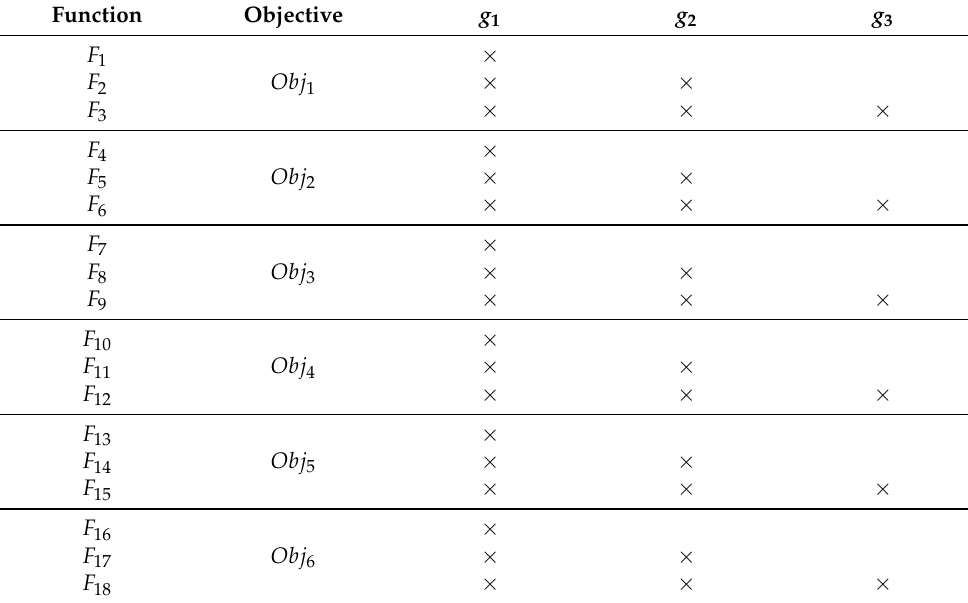
Table 2. Components of the 18 test functions.